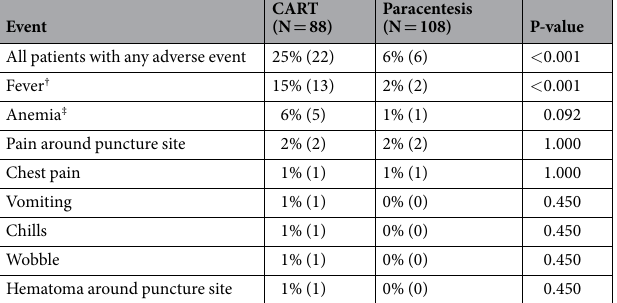
Table 5. Adverse events. There were no fatal adverse events. † Defined as body temperature elevated by over 1 °C and reaching over 38 °C. ‡ Defined as hemoglobin decreased by over 1 g/dL and reaching less than under 7 g/dL. Indication method, percentage (number); P-values were calculated by the chi-square